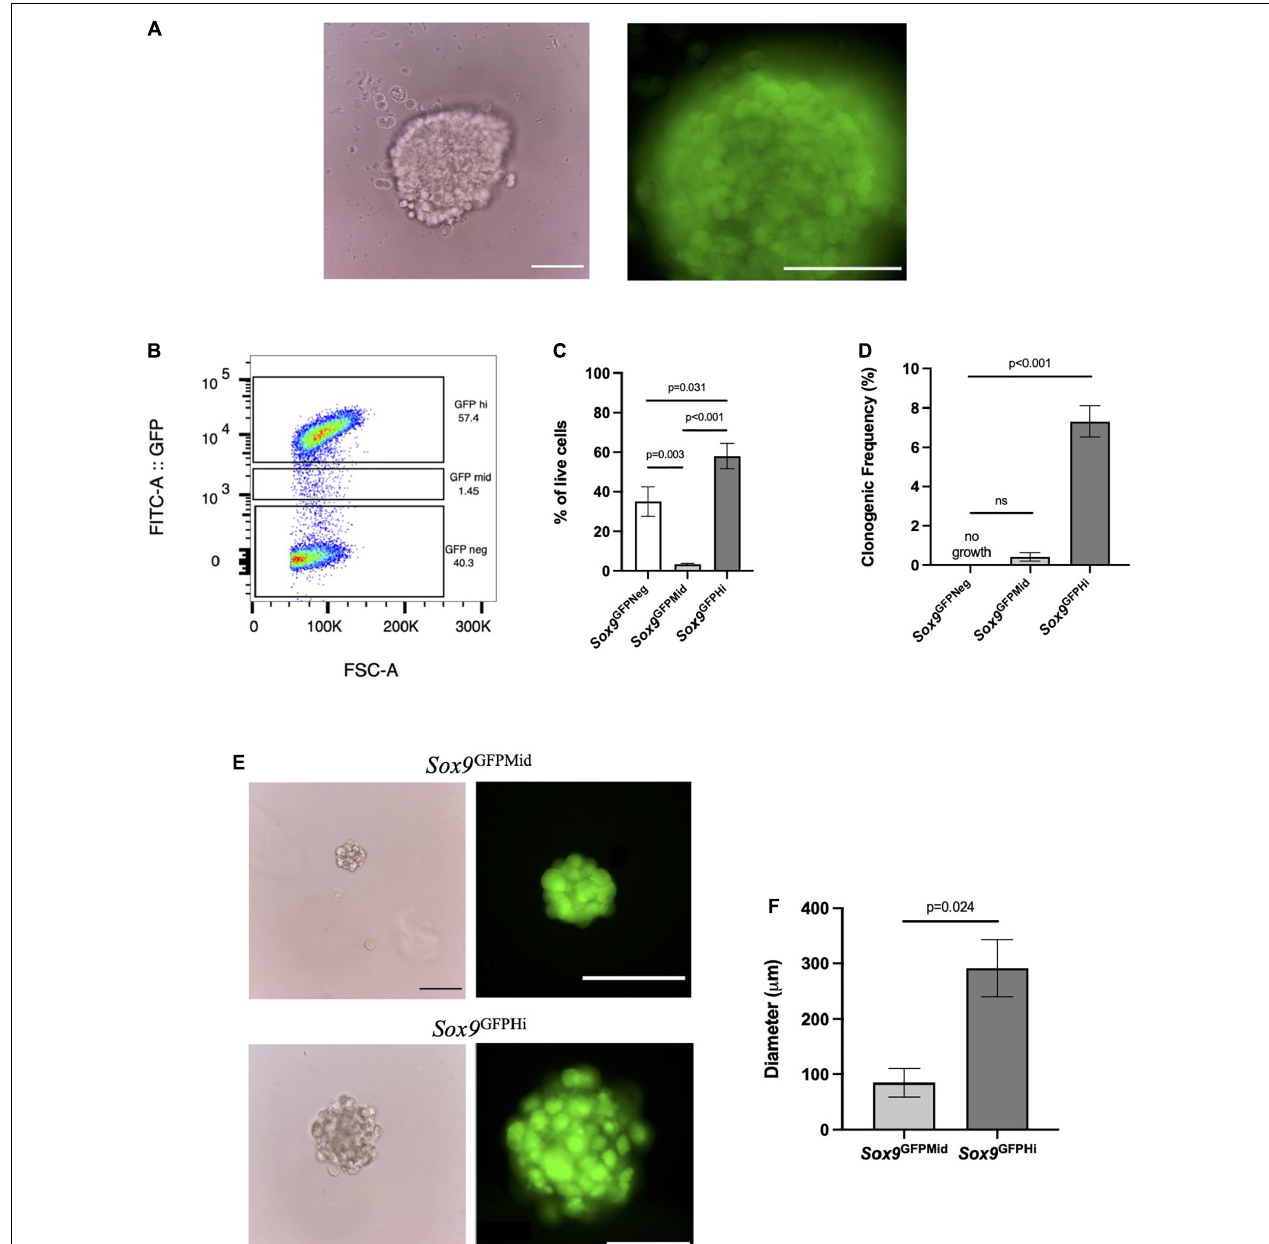
FIGURE 2 | Sox9 GFPHi chondrocytes demonstrate increased clonogenic and proliferative capacity. (A) Unsorted P7 Sox9 GFP femoral chondrocytes after 3 weeks in methylcellulose (MC), Scale bar = 100 µ m. (B) Representative FACS gating strategy and (C) frequency of live cells in Sox9 GFP fractions; n = 6 biological replicates and p -values calculated using one-way ANOVA with Tukey’s correction for multiple comparisons. (D) Clonogenicity of Sox9 GFP fractions in MC; n = 3 biological replicates and p -values calculated using One-Way ANOVA with Tukey’s correction for multiple comparisons. (E) Representative images of mid (upper row) and high (lower row) Sox9 GFP chondrospheres in MC after 4 weeks, scale bar = 100 µ m. (F) Average diameter of chondrospheres in MC, n = 2 biological replicates, p -value calculated with unpaired t -test. All error bars represent mean ± SEM.